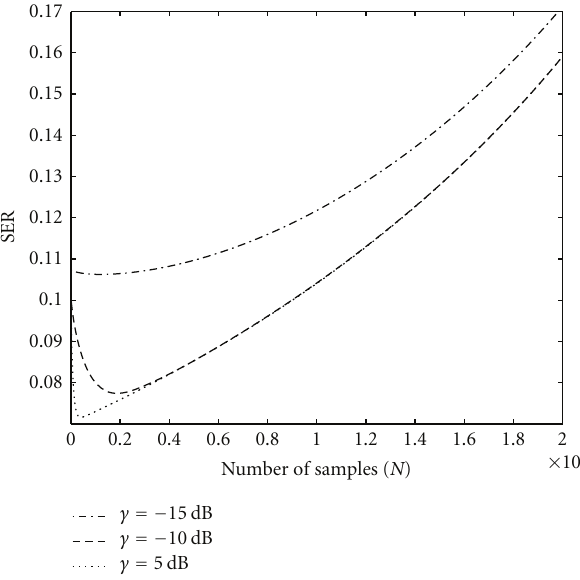
Figure 2: SER as a function of the number of samples ( N ).